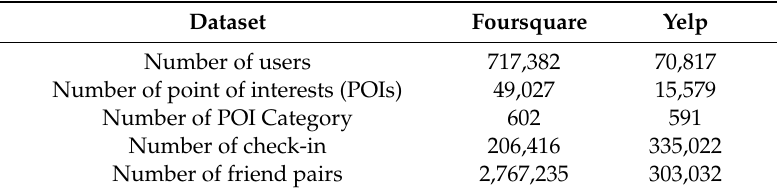
Table 1. Statistics of the two data